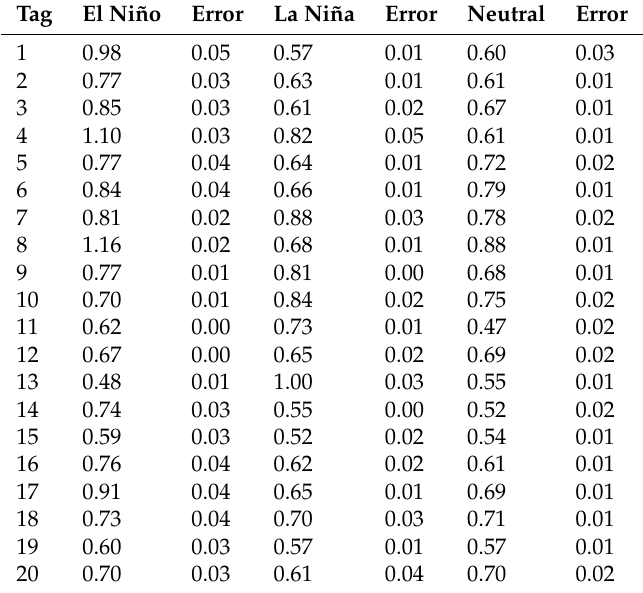
Table A3. The DFA coefficient ( α ) of solar radiation for more than ten